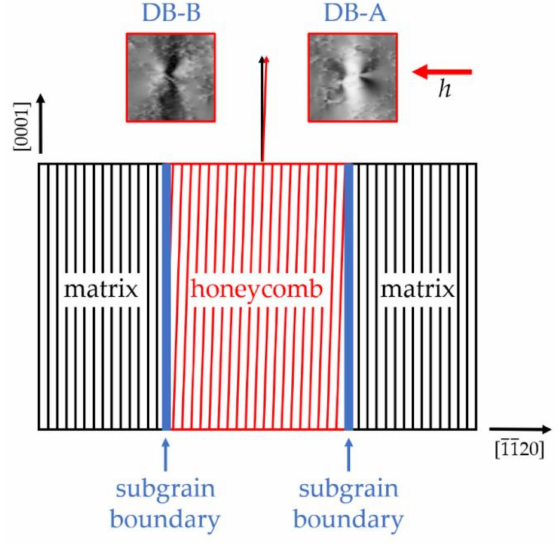
Figure A3. Phenomenological model concerning the contrast inversion of the rosettes of the DBs owing to two subgrain boundaries that have to be passed by the X-ray beam (see text for explanation).